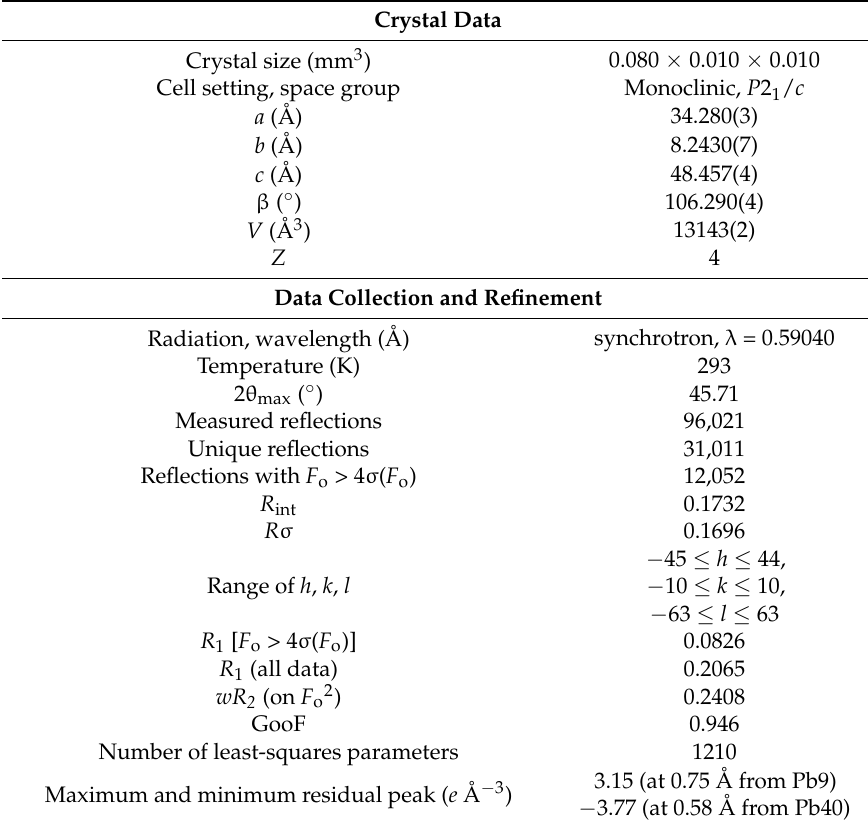
Table 1. Crystal and experimental details for thallium-bearing